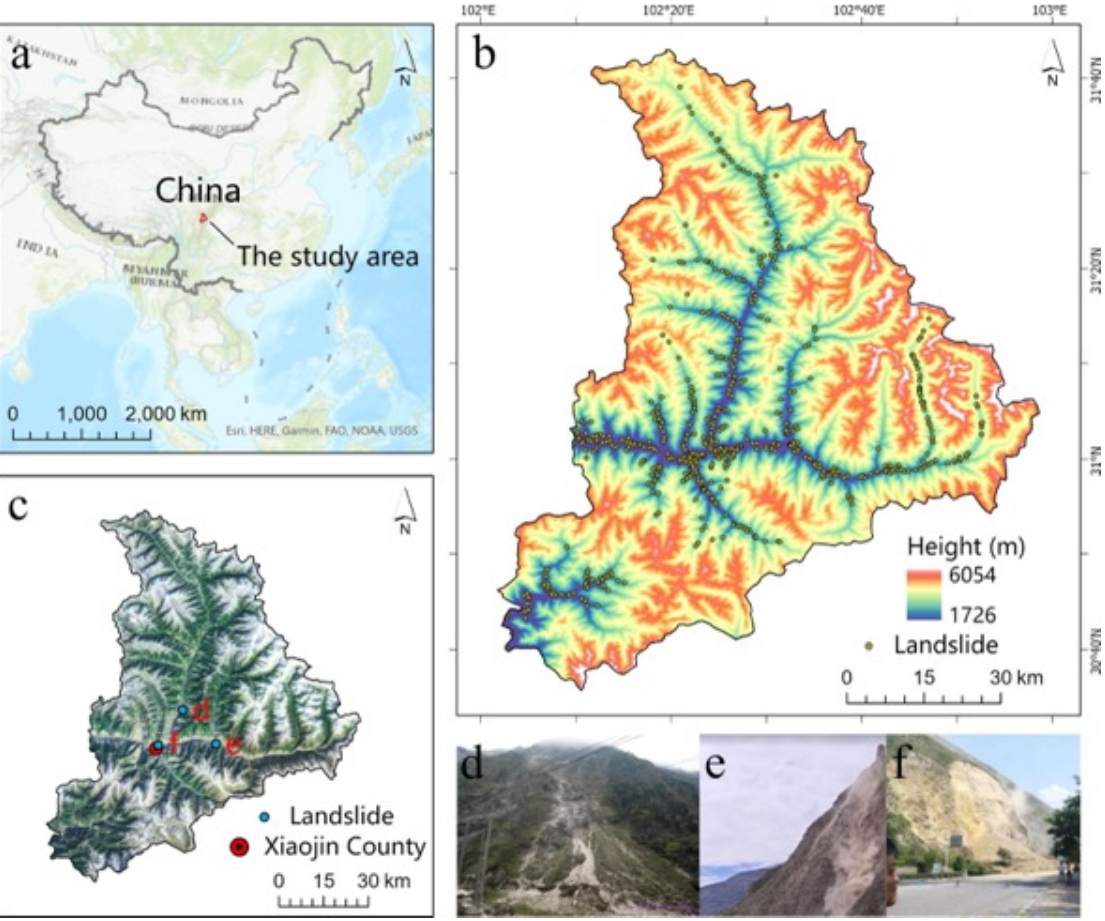
Figure 1. ( a ) The location of the study area. ( b ) Remote sensing images of the study area and the location of the three landslide cases. ( c ) Landslide inventory map and elevation map of Xiaojin County. ( d–f ) The landslide cases in the study area, d, e, and f are flow, fall, and slide respectively.